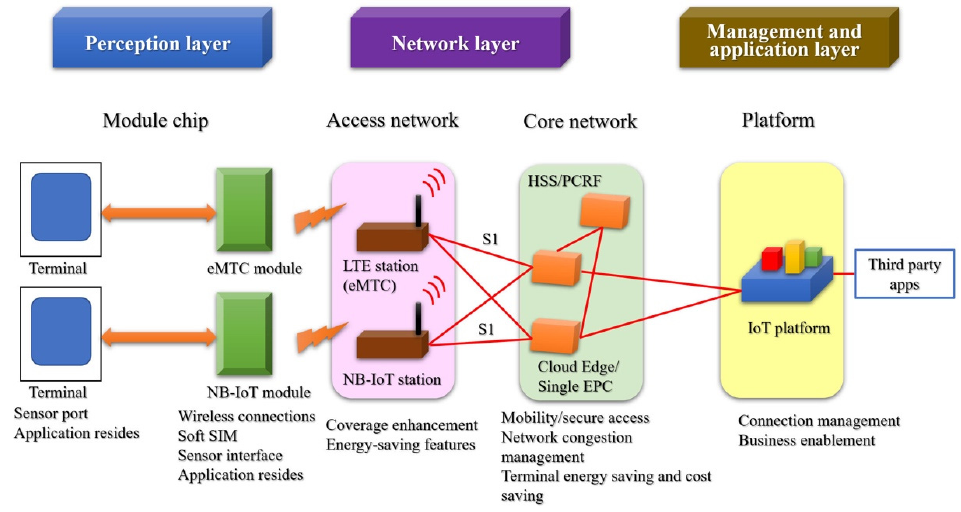
Figure 13. IoT technology architecture.